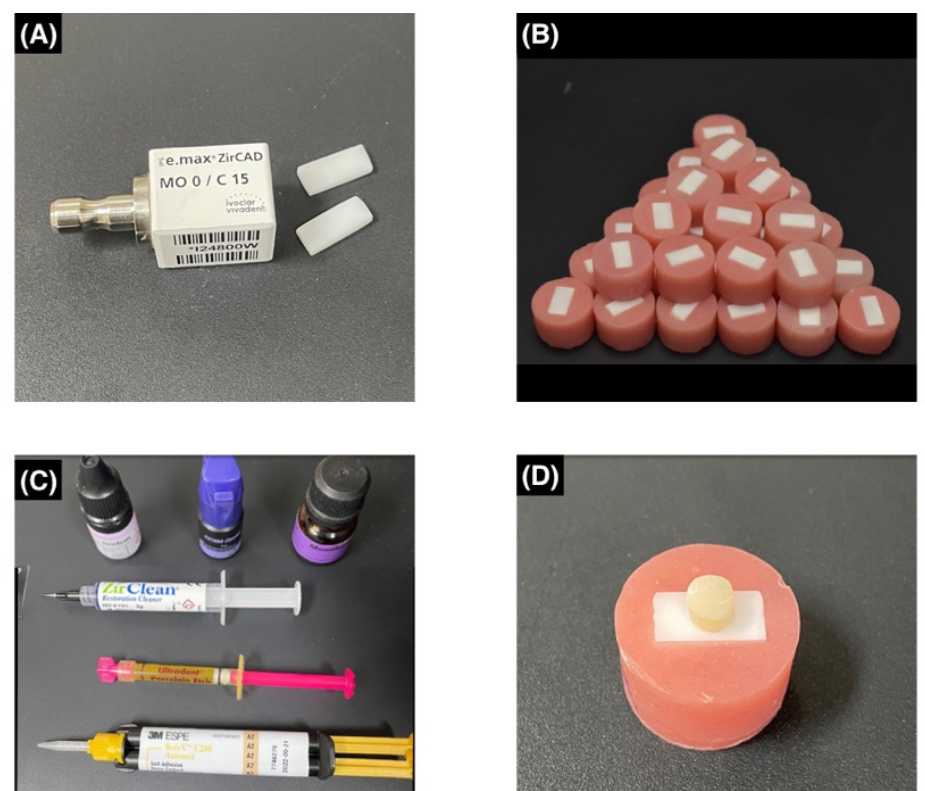
Figure 2. Steps of specimens’ preparation: ( A ) Cutting of rectangular-shaped pre-sintered zirconia blocks (IPS e.max ZirCAD, Ivoclar Vivadent, Schaan, Liechtenstein); ( B ) Embedded zirconia in acrylic resin; ( C ) Materials used for surface cleaning and bonding; and ( D ) Resin cement cylinder bonded to zirconia surface.